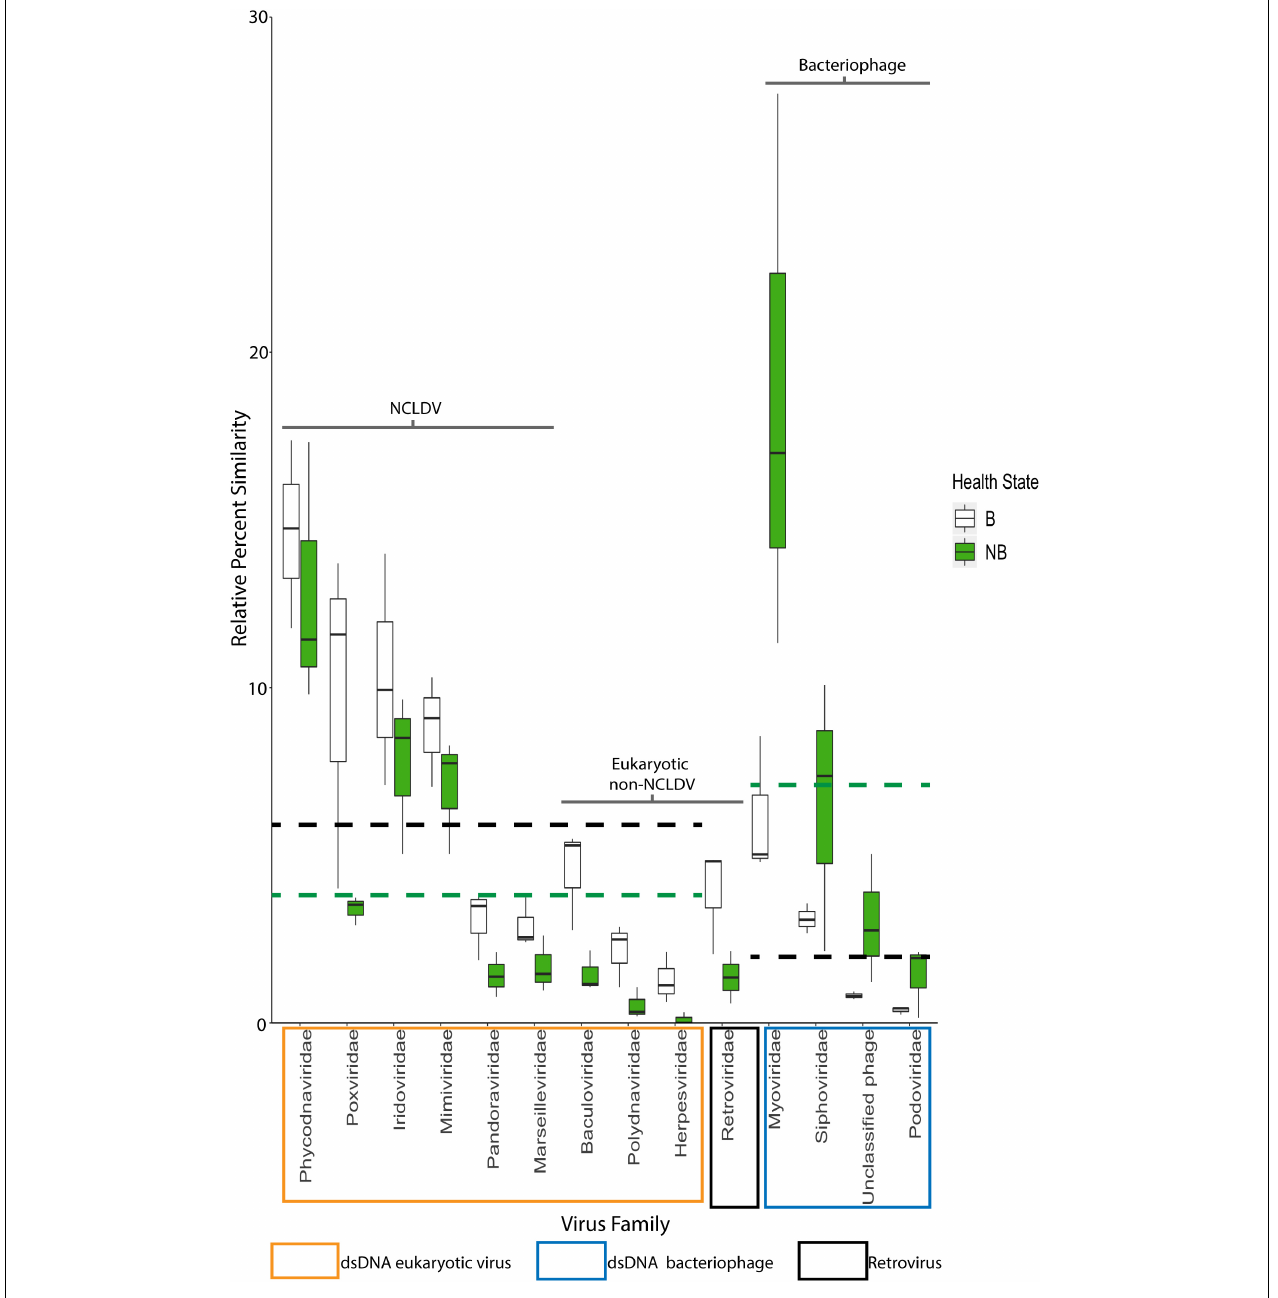
FIGURE 5 | Relative percent of similarities (y-axis) to virus families (x-axis) identified after viral homology analysis of each individual metagenome ( N = 3). Of the 26 viral families annotated, these 14 families represent those with > 5% similarities and/or families with significant differences between B and NB viral metagenomes ( Baculoviridae, Herpesviridae, Polydnaviridae, Retroviridae, and Myoviridae, Podoviridae, and Siphoviridae ). Viral families are boxed by viral group: eukaryotic viruses (orange), retroviruses (black) and bacteriophage (blue). NCLDV families are indicated by the black bracket. Dashed lines indicate average mean across eukaryotic and bacteriophage families for B (black) and NB (green) samples. A general trend of more similarities to dsDNA eukaryotic viruses for B than NB viral metagenomes, and more similarities to dsDNA phage for NB than B viral metagenomes is visible. Additionally, there is a significant increase ( p < 0.05) in the relative percent of similarities to Retroviridae in the B (3.9%) compared to the NB (1.4%).